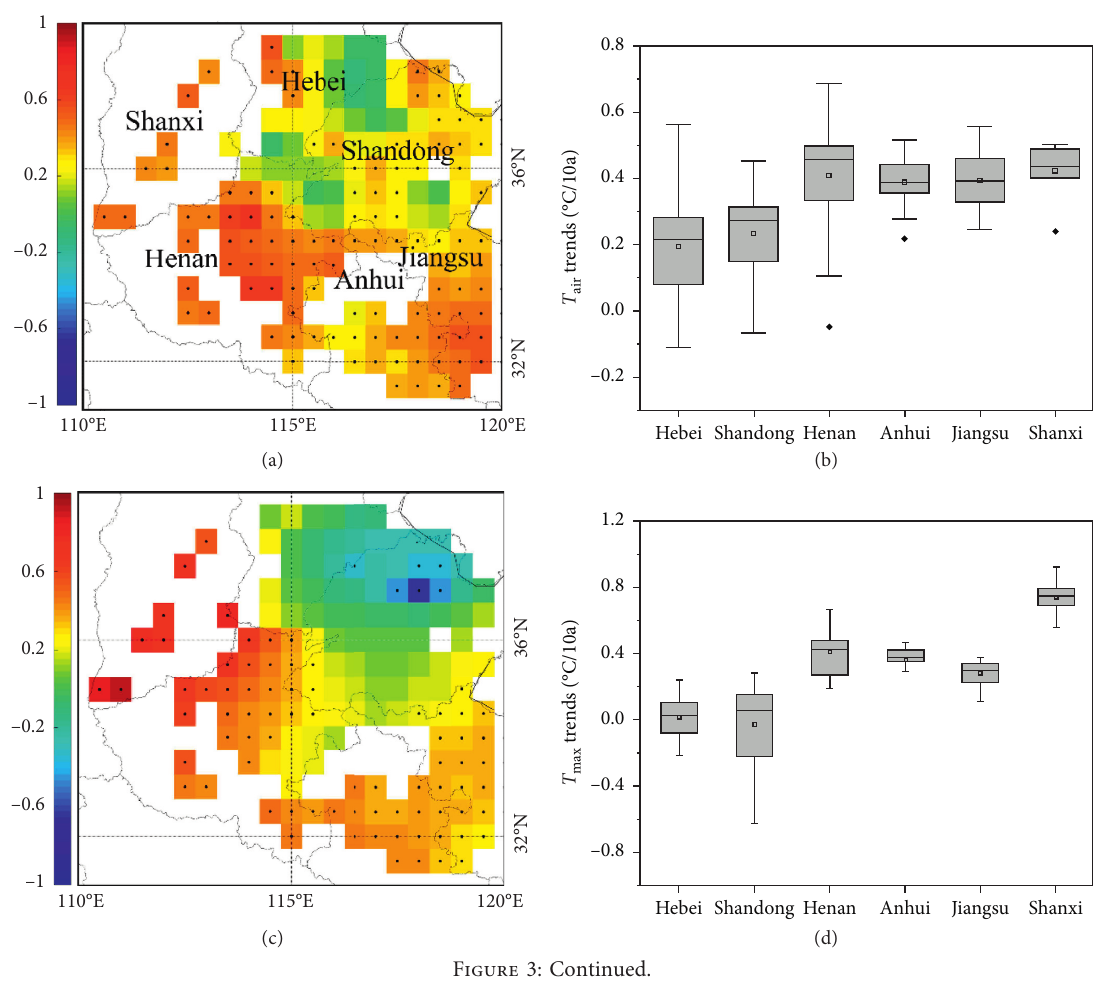
air . (b) T max . (c) T min . (d)